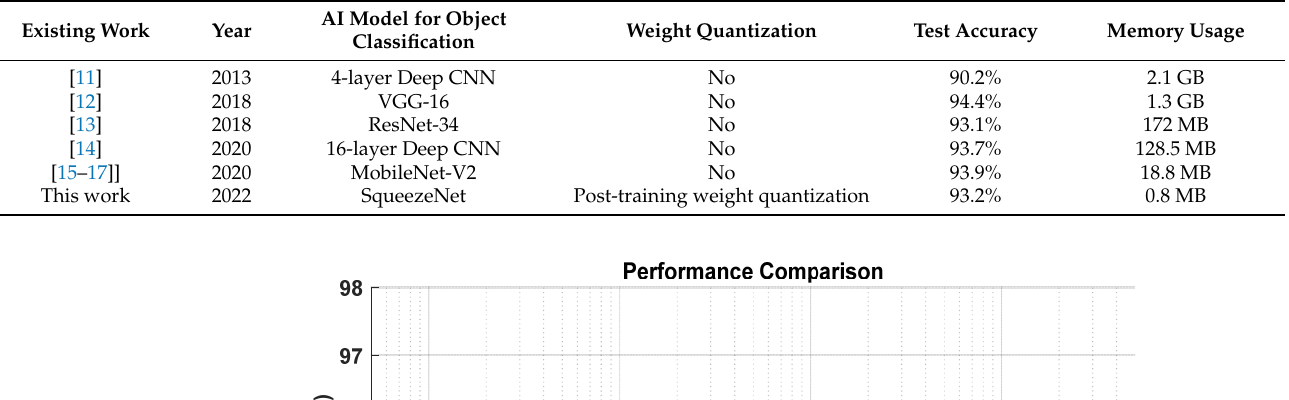
Table 9. Comparison of this work with existing AI Models when running experiments on our developed dataset.